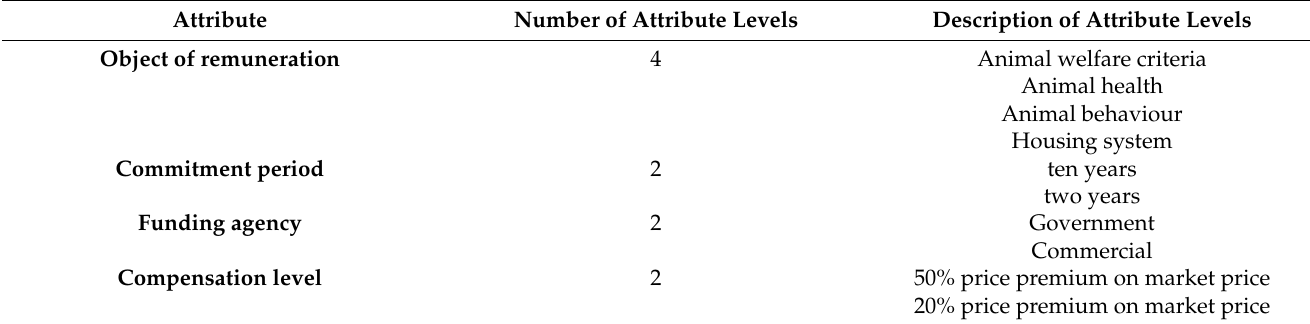
Table 1. Attributes and attribute levels of the choice-based conjoint